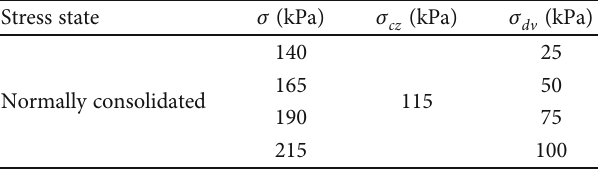
Table 6: Stress calculations of normally consolidation clay. Stress